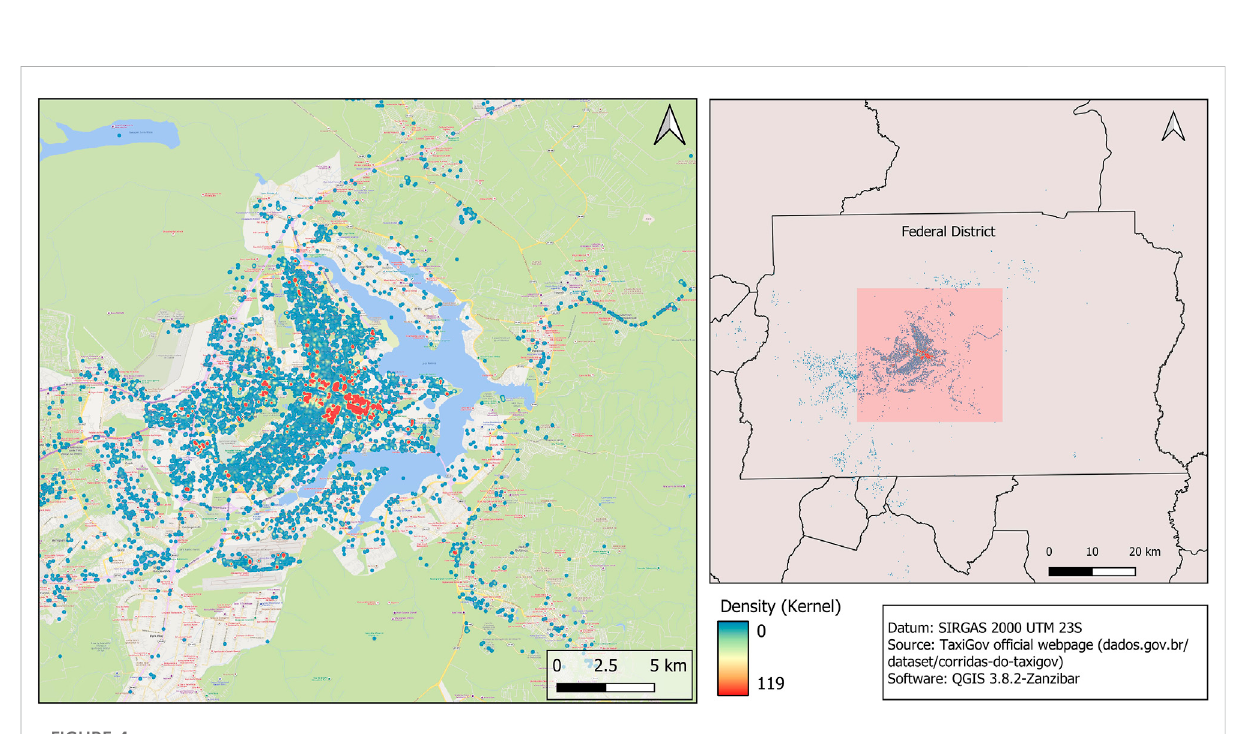
FIGURE 4 Heatmap of the most common destinations of meeting trips in the